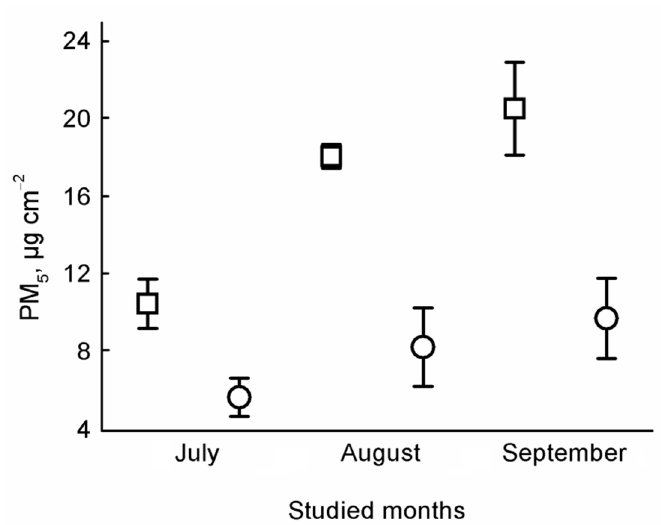
Figure 2. Average (± standard error) concentrations of PM 5 in the leaves and traps. Notations: open square means PM 5 concentrations in traps, open circle means PM 5 concentrations on leaves.